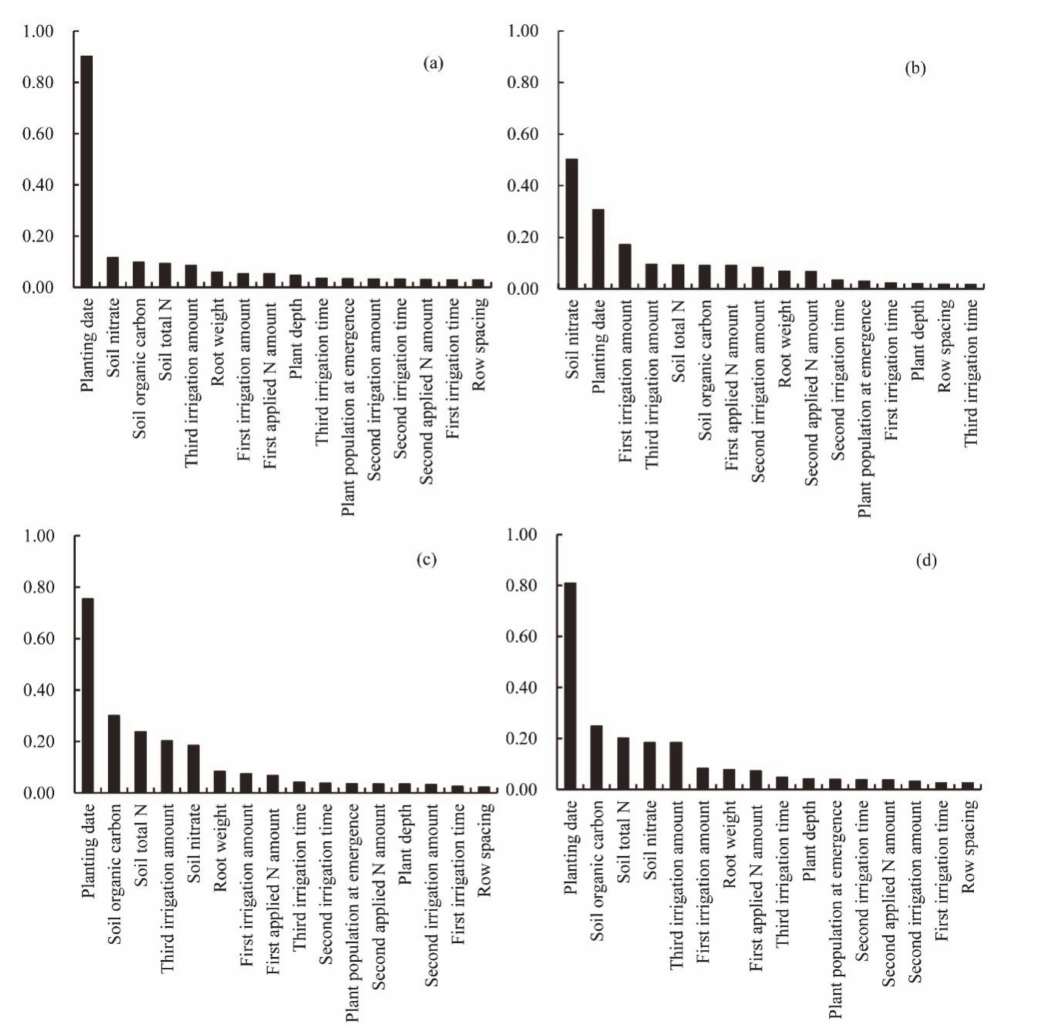
Figure 5. EFAST sensitivity analysis results for selecting adjusted variables using leaf nitrogen content (LNC) as the state variable. Sensitivity of ( a ) GPC; ( b ) LNC at the booting growth stage; ( c ) LNC at the anthesis growth stage; ( d ) LNC at the grain filling growth stage to soil and field management